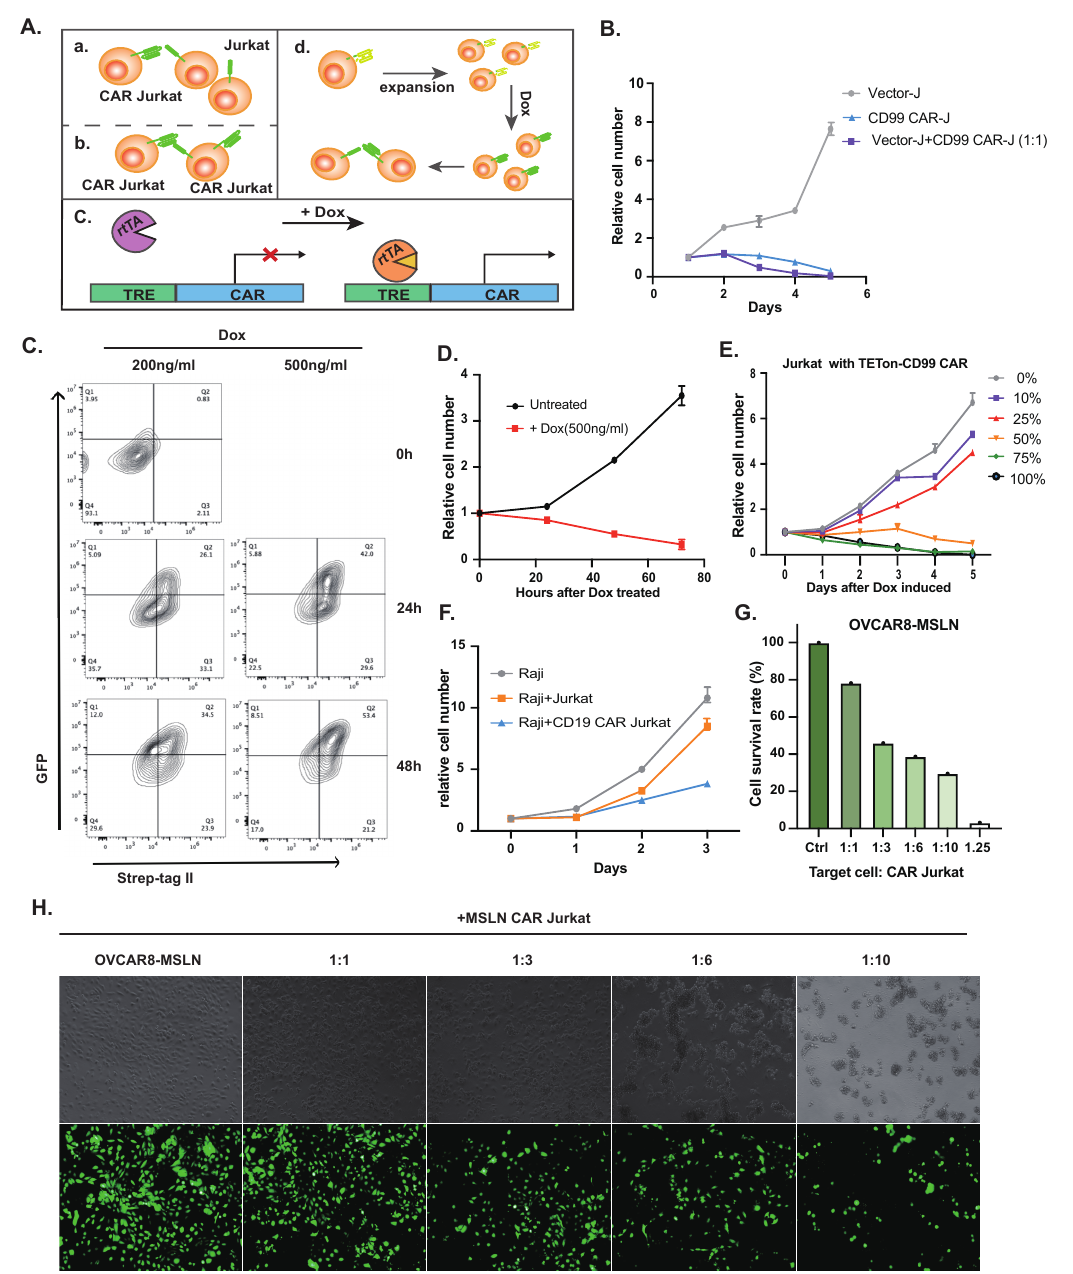
Figure 2. Schematic illustration of CAR Jurkat cells killing untreated ( a ) and CAR-transduced ( b ) Jurkat cell lines; mechanism of the Tet-On system ( c ); mechanism of TET on system ( d ) ( A ). Relative cell growth of Jurkat cell lines mixed with CD99 CAR-transduced Jurkat cell lines (1:1) ( B ). Flow cytometry detect the expression of CD99 CAR on Jurkat cell lines at 24 h and 48 h after treatment with Dox (200 ng, 500 ng) ( C ). Relative cell growth of Jurkat cell lines transduced with Tet-On system after treatment of Dox (500 ng) ( D ). Relative cell growth of Jurkat cell lines mixed with Jurkat cell lines transduced with Tet-On system after treatment with Dox (500 ng) in 5 gradients (10%, 25%, 50%, 75%, 100%) ( E ). Relative cell growth of Raji cell lines mixed with untreated Jurkat cell lines or CD99 CAR-transduced Jurkat cell lines (1:3) ( F ). Relative cell growth of MSLN-overexpressed OVCAR-8 cell lines mixed with MSLN CAR-transducing Jurkat cell lines in different proportions ( G ). MSLN-overexpressed OVCAR-8 cell lines has the expression of green fluorescent protein (GFP); the survival of OVCAR-8 cell lines after co-incubation with MSLN CAR Jurkat cell lines after 48 h was visualized via fluorescence microscopy ( H